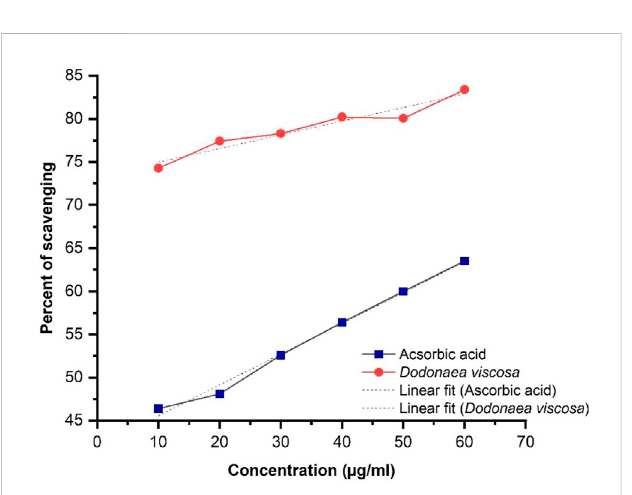
FIGURE 2 DPPH activity of ethanol extract of Dodonaea viscosa leaves.